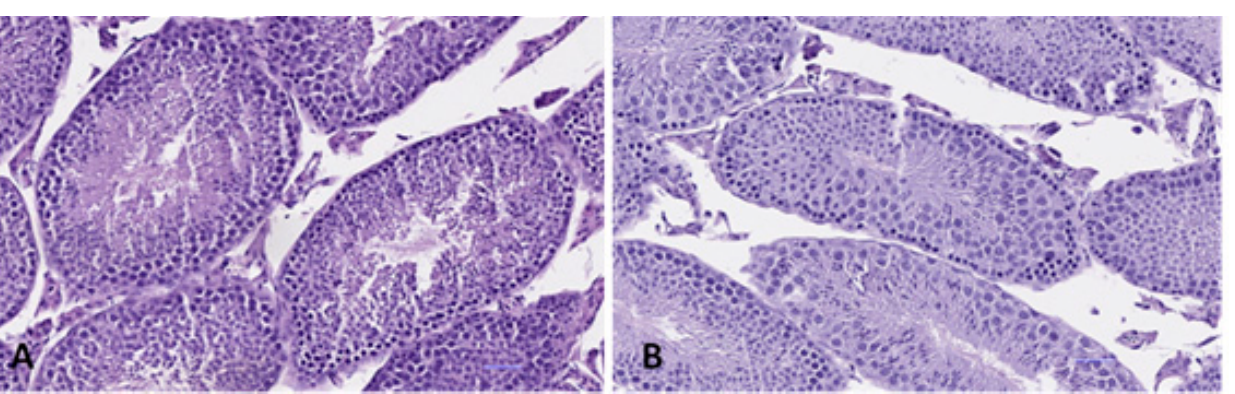
Figure 10. Histological sections of ovaries in female mice from the control group ( A ) and group 5 ( B ), (H-E 20×).